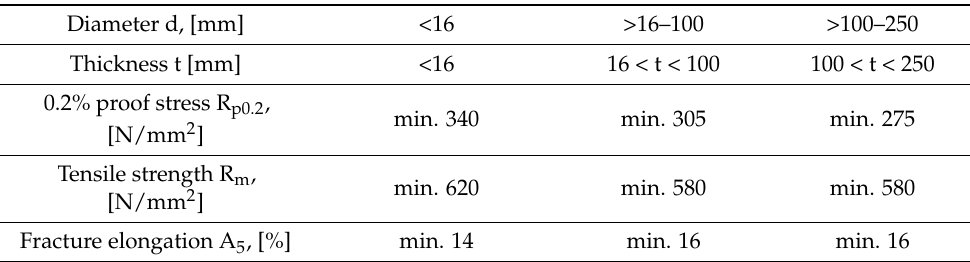
Table 2. Mechanical properties of steel C45 (1.0503) in the normalized state.